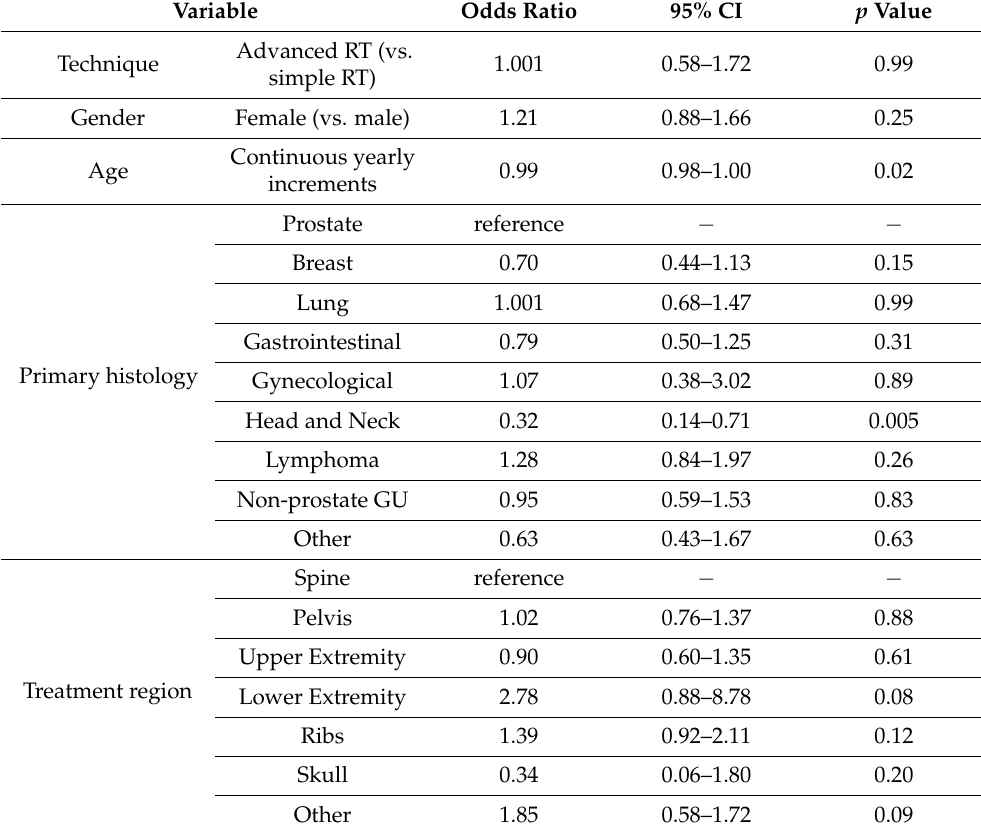
Table 3. Multivariable analysis of partial pain response.